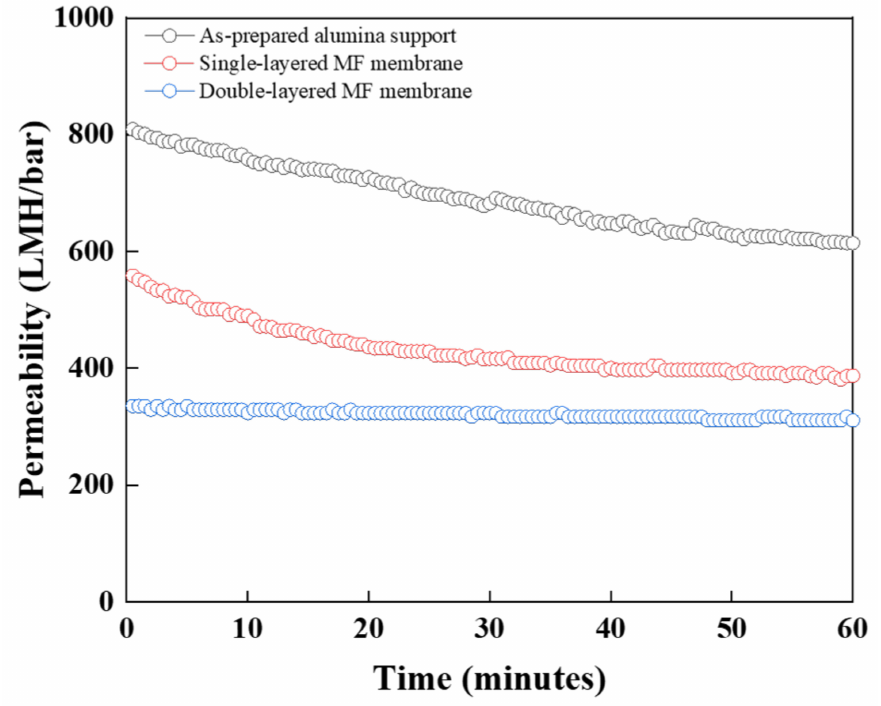
Figure 7. Pure water permeability of extruded support layer and alumina microfiltration (MF)